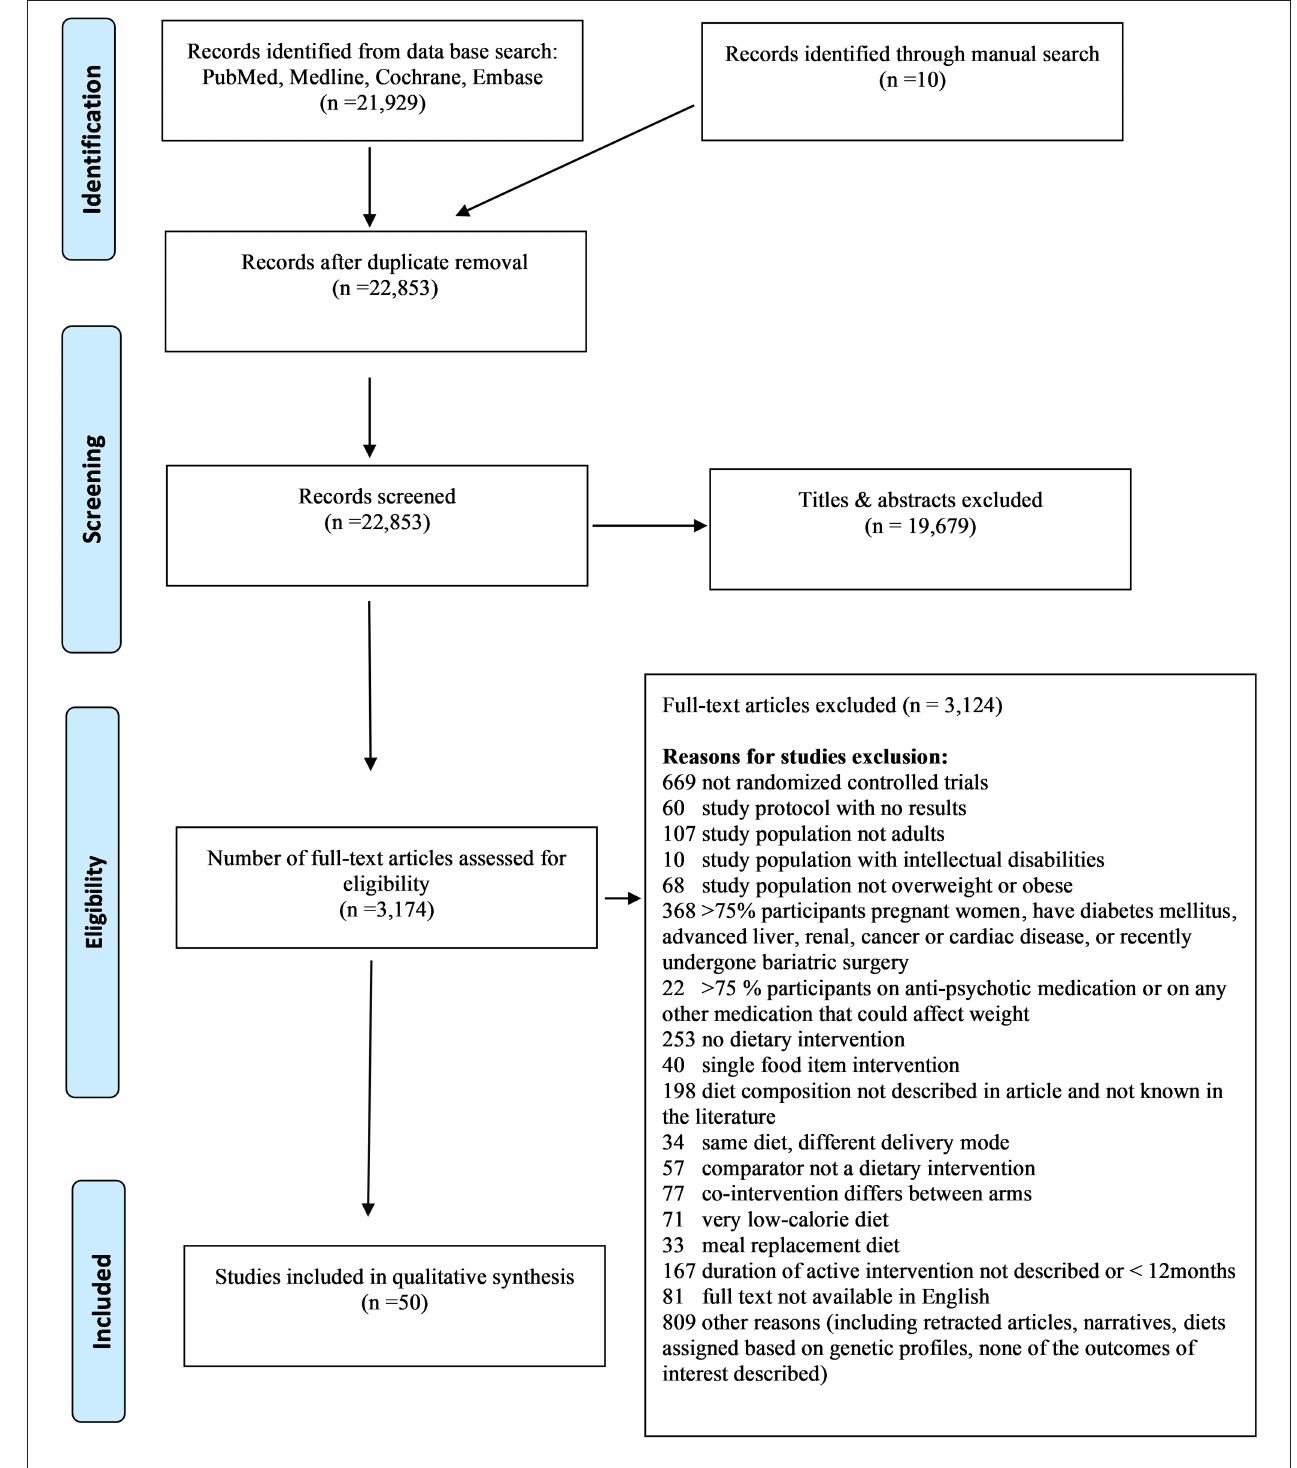
FIGURE 1 | Flow diagram of included